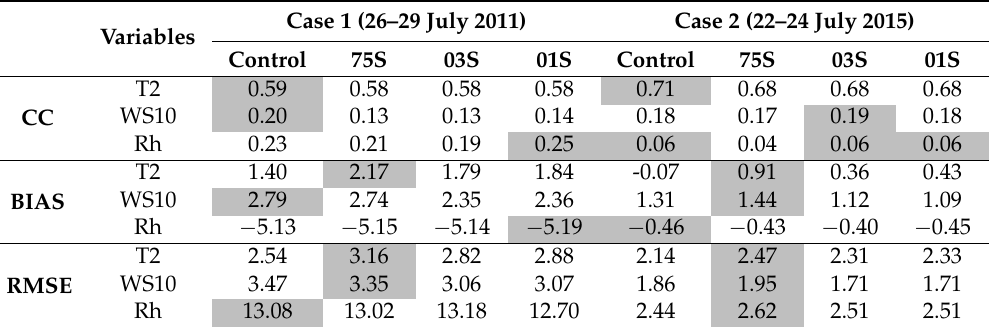
Table 5. Prediction statistics against AWS observations for Case 1 (26 July 2011 to 29 July 2011) and Case 2 (22 July 2015 to 24 July 2015). Shaded boxes are maximum